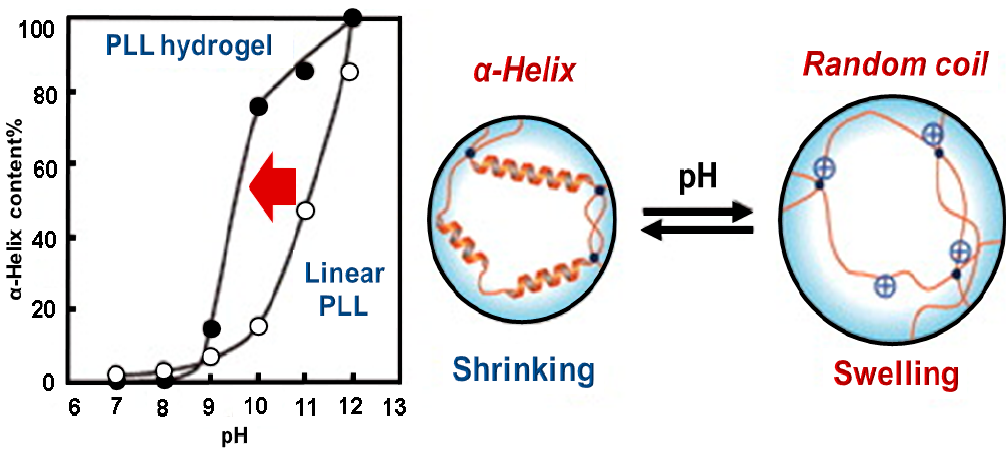
Figure 2. Illustration of the structural change of poly( L -lysine) from α -helix to random coil in response to pH change. Reproduced with permission from [54]. Copyright 2015, The Chemical Society of Japan.